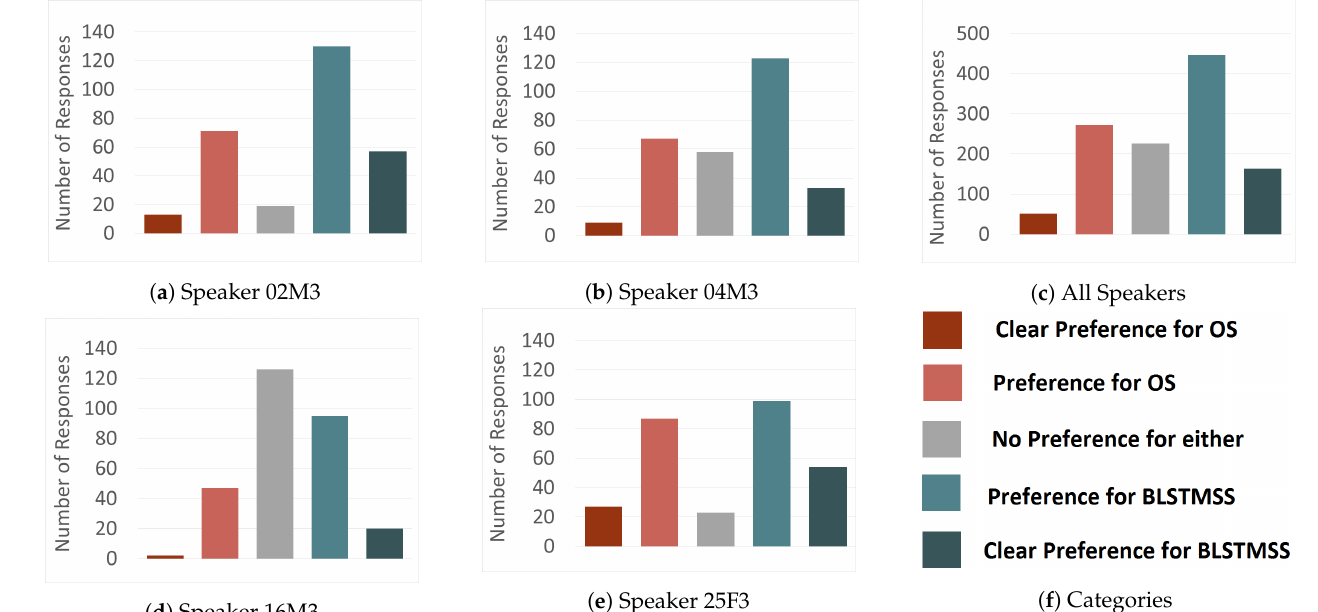
Figure 8. Histogram plots for the preference scores of the four speakers separately and all